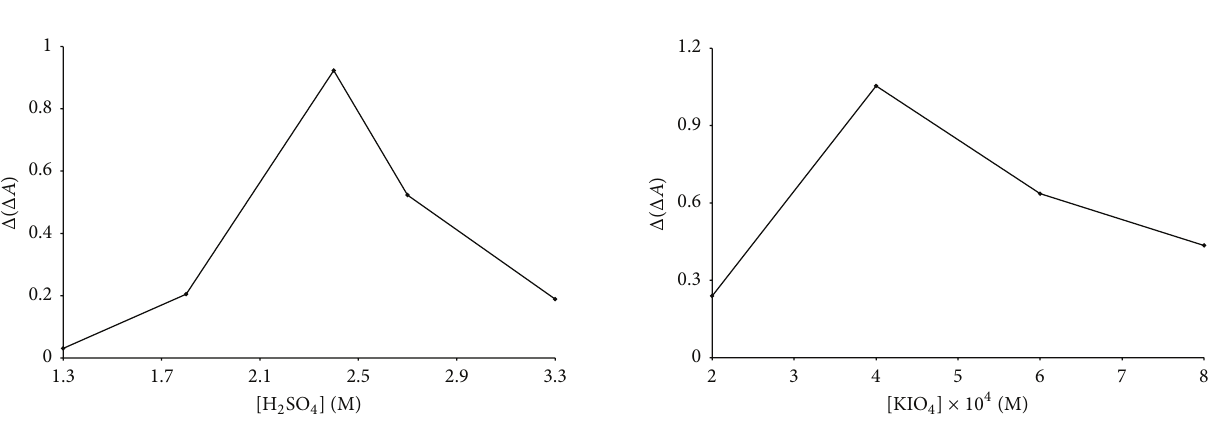
Figure 3: Effect of H 2 SO 4 on the sensitivity. Conditions: SCG; 12ngmL −1 ; TBAB, 1.1 × 10 −3 M; amaranth, 1.4 × 10 −4 M, IO 4− 4.0 × 10 −4 M; temperature, 25 ∘ C.